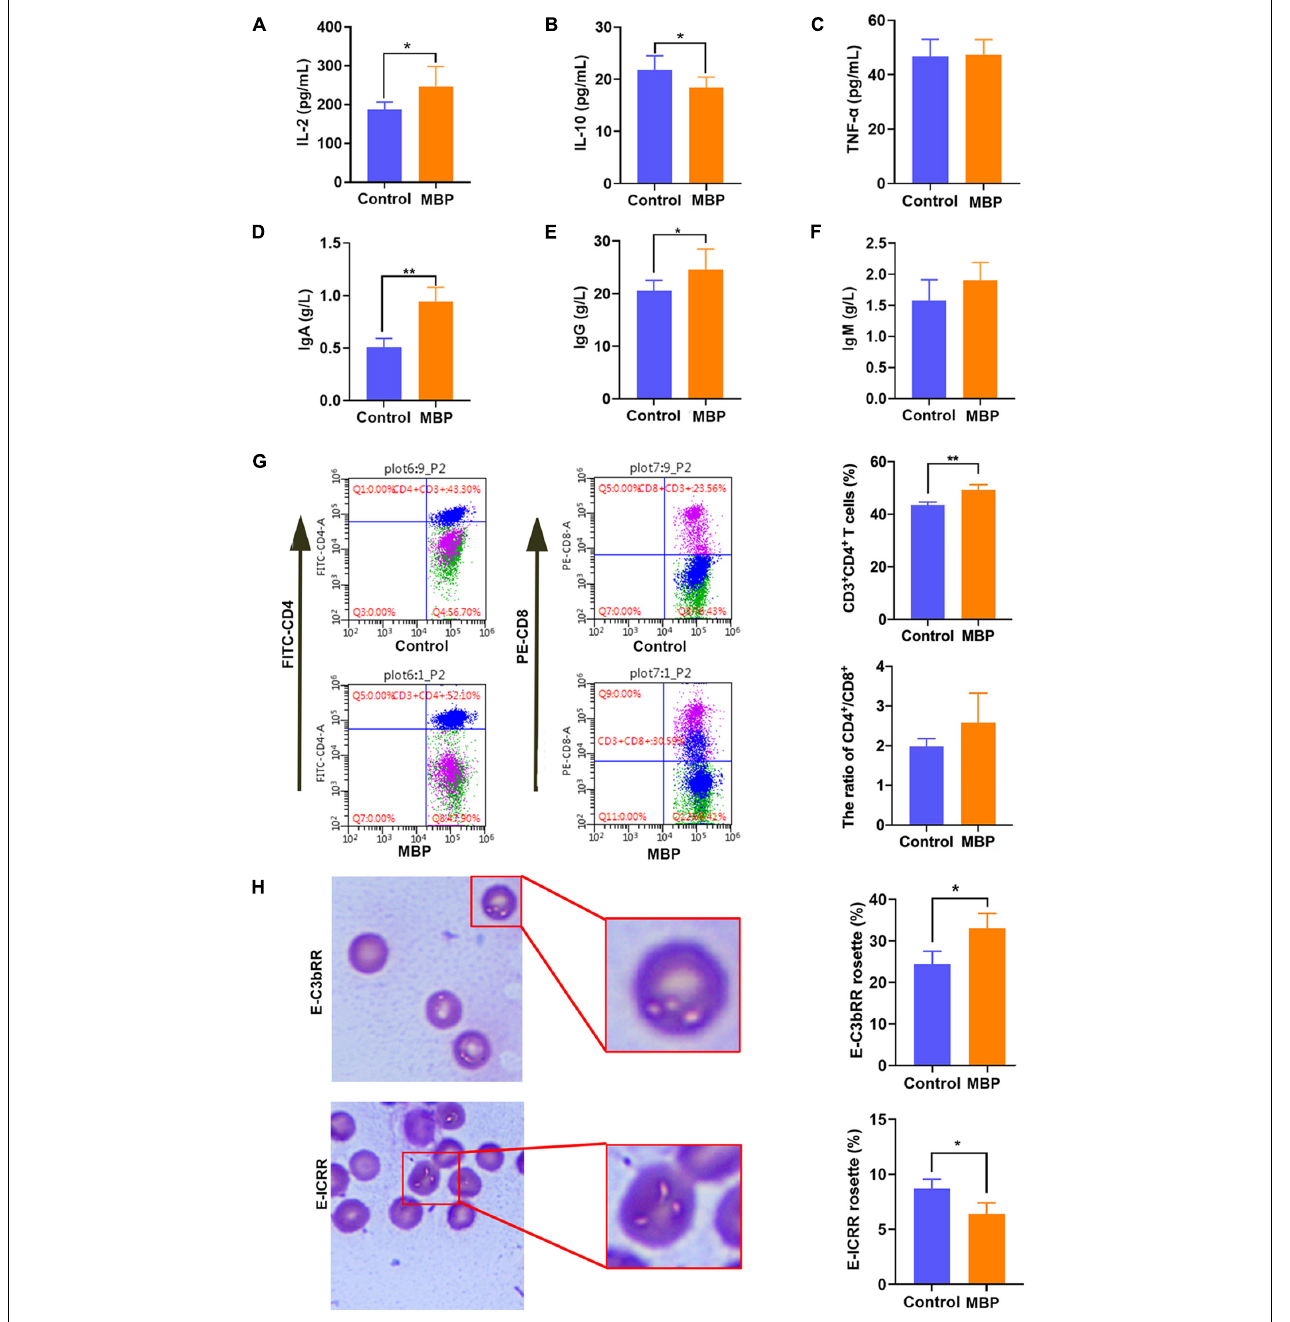
FIGURE 1 | Effects of MBP on the immunity of sows on day 7 postpartum. (A–C) Concentration of IL-2, IL-10, and TNF- α in the serum of sows. (D–F) Concentration of immunoglobulins IgA, IgG, and IgM in the serum of sows. (G) T lymphocyte subsets in peripheral blood detected by flow cytometry. (H) Differences in E-C3bRR and E-IC rosette ratios were discerned for comparing of erythrocyte immune function. Data represent mean ± SD. * p < 0.05, ** p < 0.01 versus